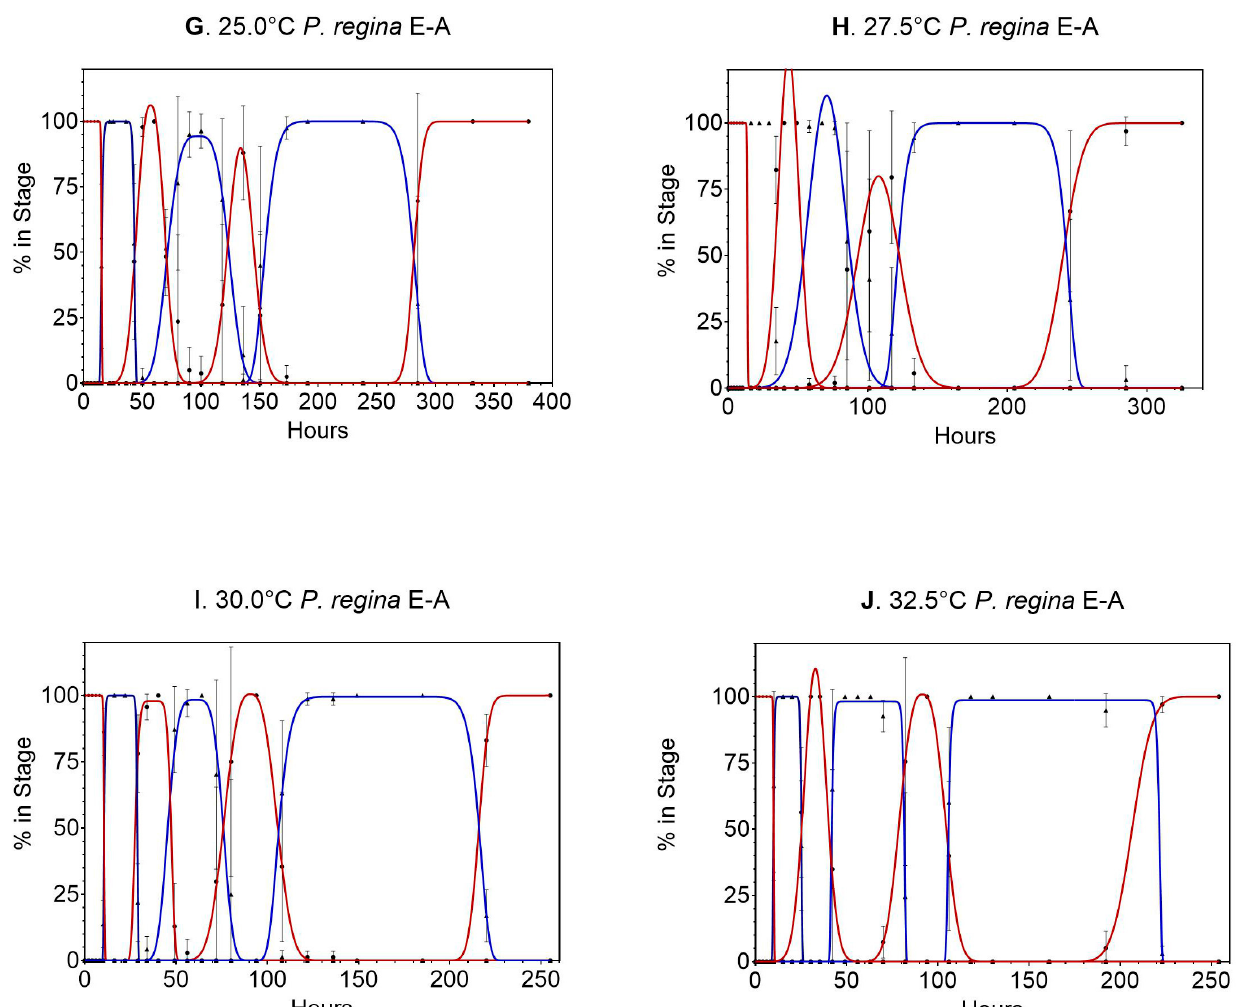
Figure 3. ( A – F ) Gaussian and modified Gaussian curves (those curves with plateau) fit to all life stages (egg to adult) of Phormia regina for temperatures 10.0 to 32.5 ◦ C (Figure 1A–J, respectively). Models were not constrained, so occasionally the best fit curve can exceed 100%. Different line colors and black dot and triangles are used to distinguish adjacent curves. ( G – J ) Gaussian and modified Gaussian curves (those curves with plateau) fit to all life stages (egg to adult) of Phormia regina for temperatures 10.0 to 32.5 ◦ C (Figure 1A–J, respectively). Models were not constrained, so occasionally the best fit curve can exceed 100%. Different line colors and black dot and triangles are used to distinguish adjacent curves.